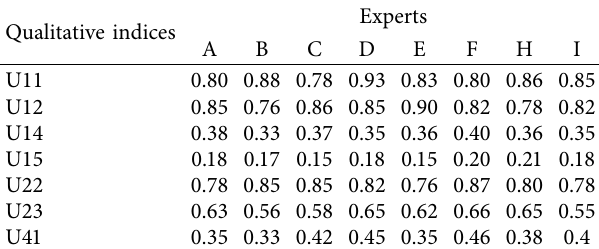
Table 8: Scoring results of qualitative